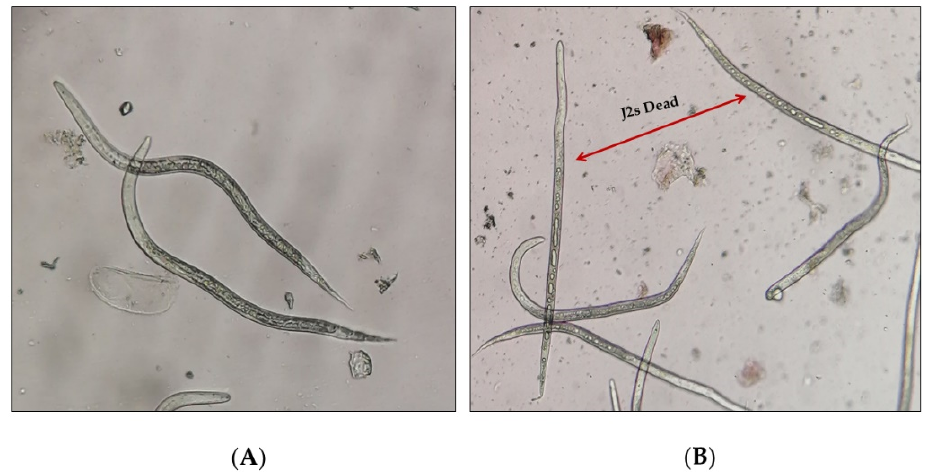
Figure 2. Second-stage juveniles (J2s) of Meloidogyne incognita in ( A ) control in distilled water, ( B ) dead and living in culture filtrate of Trichoderma virens Table 2. Mortality of second-stage juveniles of Meloidogyne spp. after 72 h exposure to culture filtrate (CF), ethyl acetate (EA), or residual filtrate (RF) fractions from tropical Trichoderma strains.